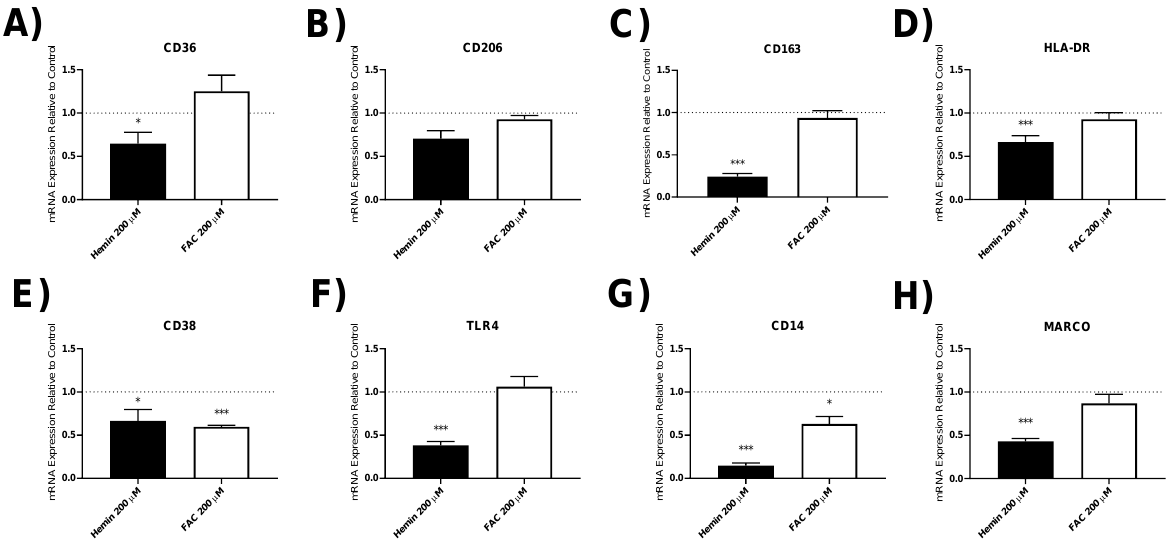
Figure 4. Macrophage polarisation markers in iron-treated lung macrophages. CD36, CD206, CD163, HLA-DR, CD38, TLR4, CD14, and MARCO expression in lung macrophages treated with 200 μM of hemin or ferric ammonium citrate (FAC) ( A – H ). Real-time qPCR was used to assess levels of gene expression after 24 h. Gene expression shown was plotted as means relative to GAPDH and an untreated control for each patient (2 −ΔΔCt ) ±SEM in smokers and COPD patients ( n = 6). Dotted line at 1 indicates untreated control. One-way ANOVAs were carried out with a post hoc Dunnett’s multiple comparisons test against time-matched untreated controls. * = p < 0.05, *** = p < 0.001.